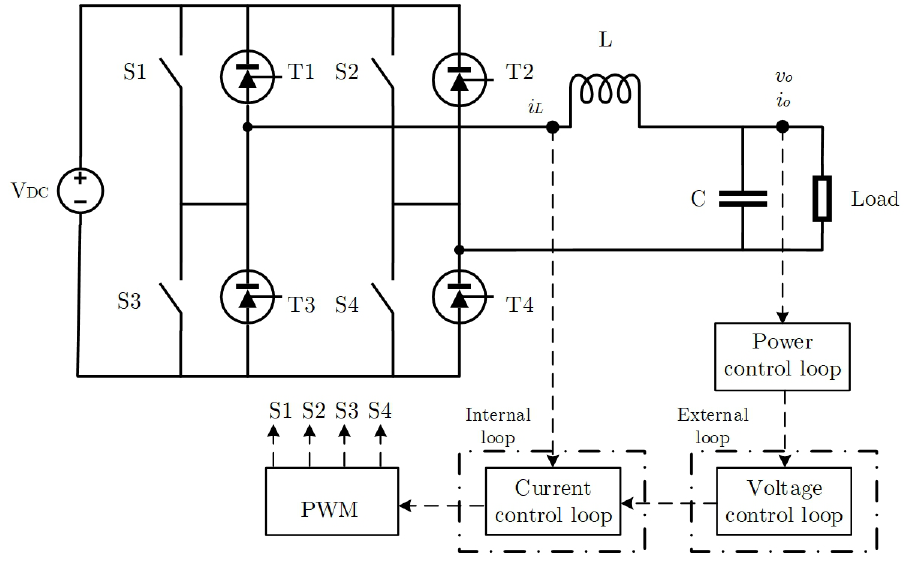
Figure 1. Single-phase inverter in islanding operation [35].